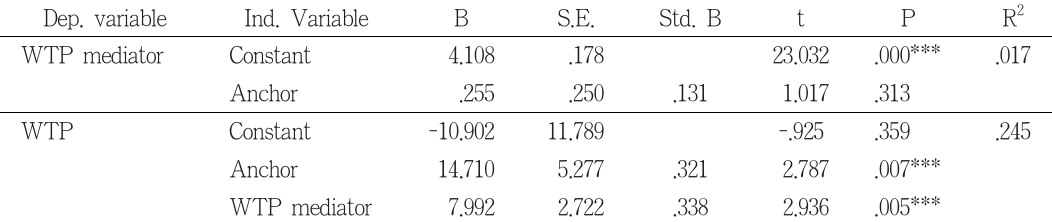
<Table 3> Results of Path Analysis in High-information Setting